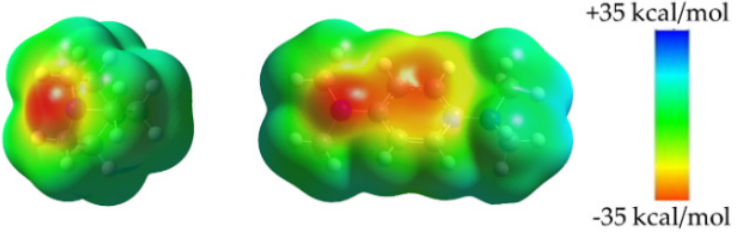
Figure 5. Electrostatic potential (calculated at 0.001 electron bohr − 3 electronic density) on the molecular surfaces of DABCO ( left ) and TMPD ( right ).